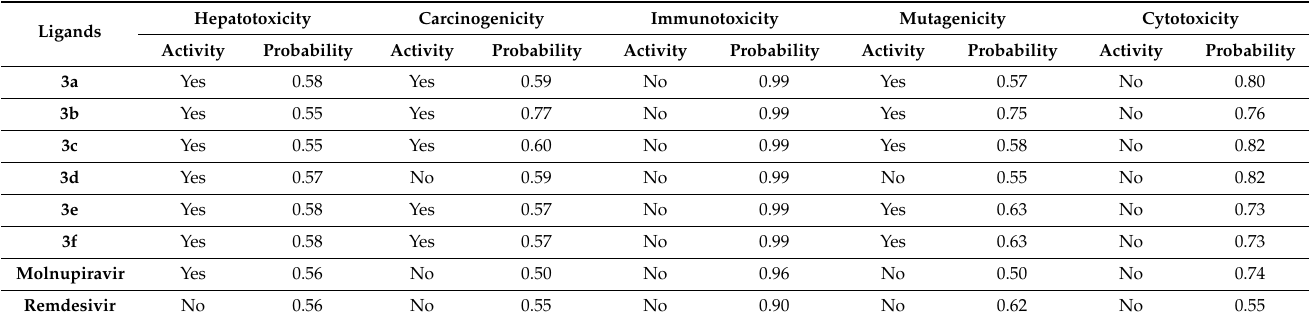
Table 4. Organ toxicity and toxicological endpoints-predicted activity calculated using the ProTox-II web server for ligands 3a–f , Molnupiravir, and Remdesivir.